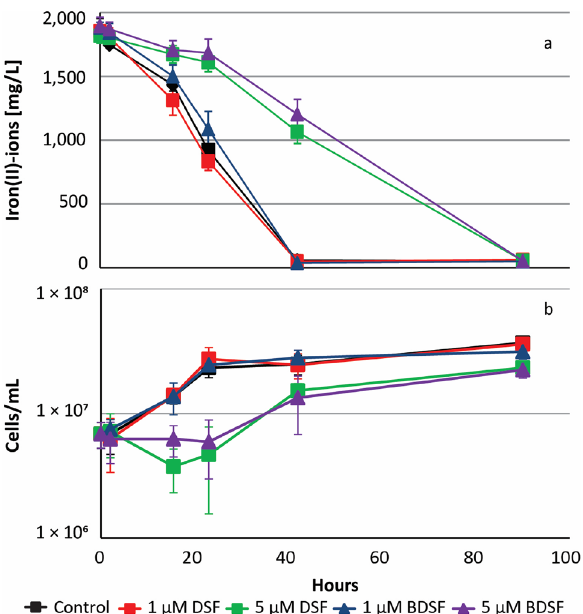
Figure 5. DSF or BDSF inhibit biological iron oxidation and cell growth. Cultures were inoculated with 10 7 cells/mL iron(II)-grown cells of L. ferriphilum T . DSF or BDSF was added at 1 or 5 µM 16 h before 32 mM iron(II)-ions were added. Cells are inhibited in iron(II) oxidation ( a ) and growth ( b ) in presence of 5 µM DSF ((Z)-11-methyl-2-dodecenoic acid, green boxes) or 5 µM BDSF ((Z) - 2-dodecenoic acid, purple